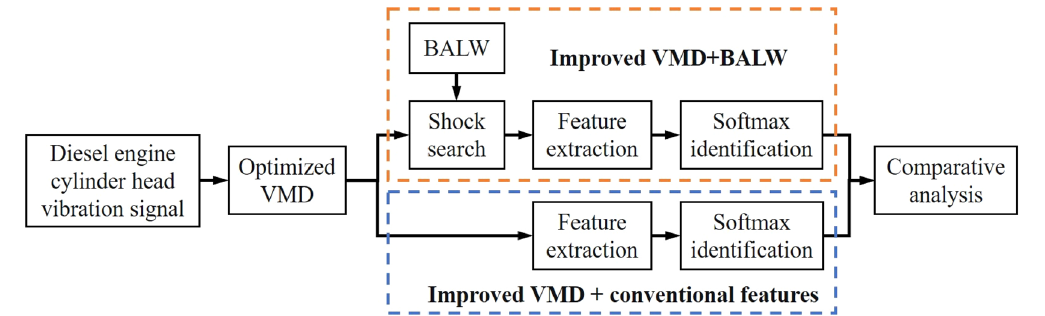
Figure 27 Fault diagnosis process